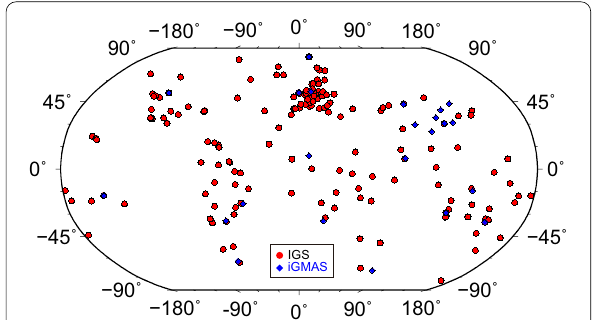
Fig. 2 Distribution of iGMAS (blue diamond) and IGS stations (red dot) with BDS tracking capability as 30 August 2021